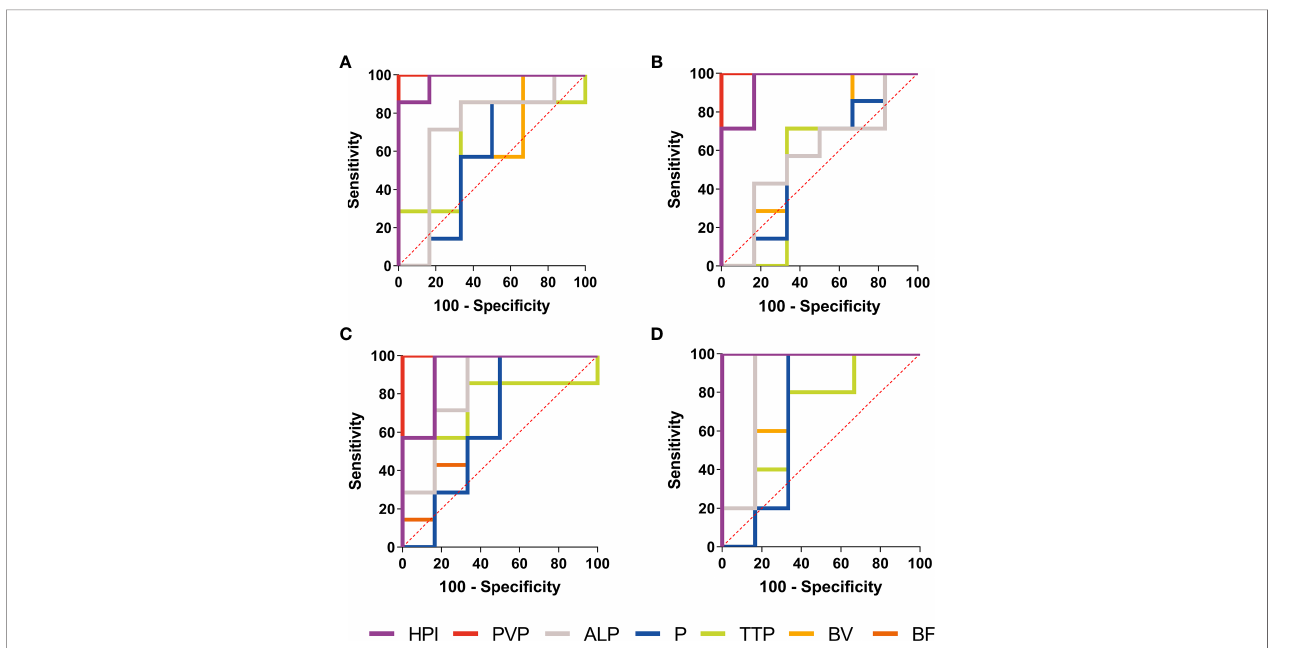
FIGURE 5 | ROC curves of the CT perfusion parameters performance in distinction of BPE and viable tumors. Receiver operating characteristic (ROC) curves of the CT perfusion parameters performance in distinction of BPE and viable tumors in Day 1 (A) , Day 3 (B) , Day 7 (C) and Day 14 (D) shown PVP value (red line) and HPI (purple line) had a perfect diagnostic ef fi ciency at each time